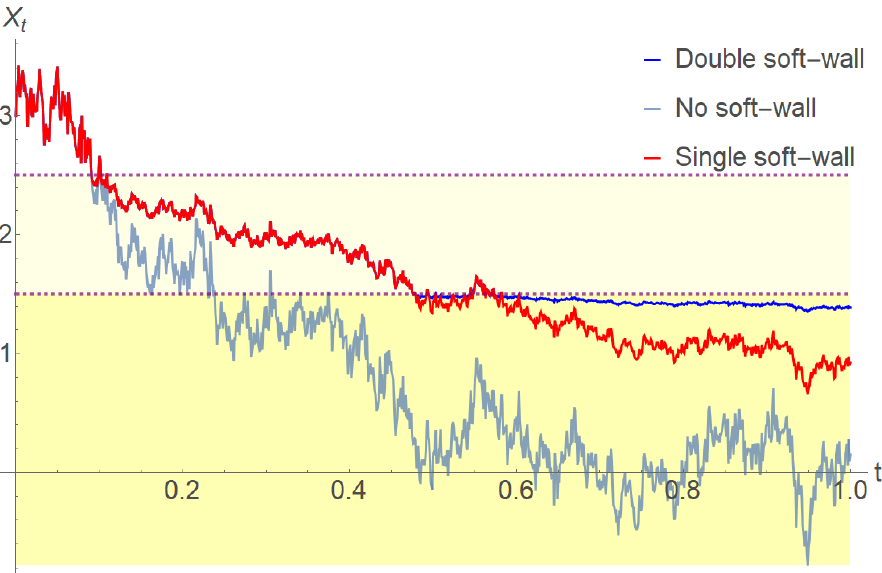
Figure 3. Trajectories of the fractional Vasicek process for α = 1, β = 3, H = 0.3, T = 1, n = 1000.